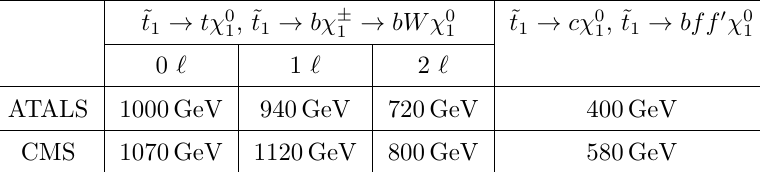
Table 3 . Current mass bounds on the stop (with a small m 13 TeV LHC with 36 fb (cid:0) 1 integrated luminosity [4{17]. The 0 ‘ , 1 ‘ and 2 ‘ mean the all-hadronic, semileptonic and dileptonic (cid:12)nal